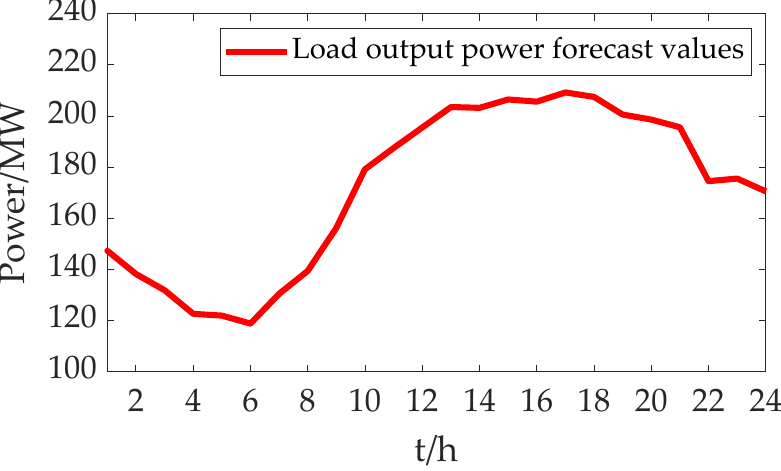
Figure 9. Load output power forecast values.